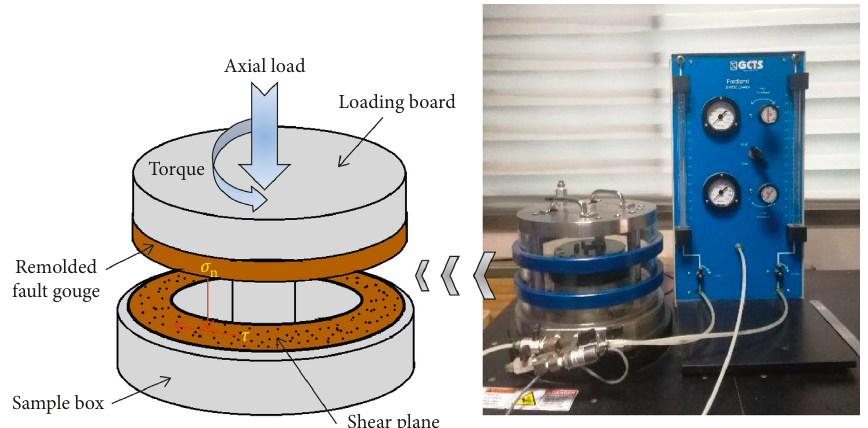
Figure 9: Bromhead ring shear apparatus and its shear